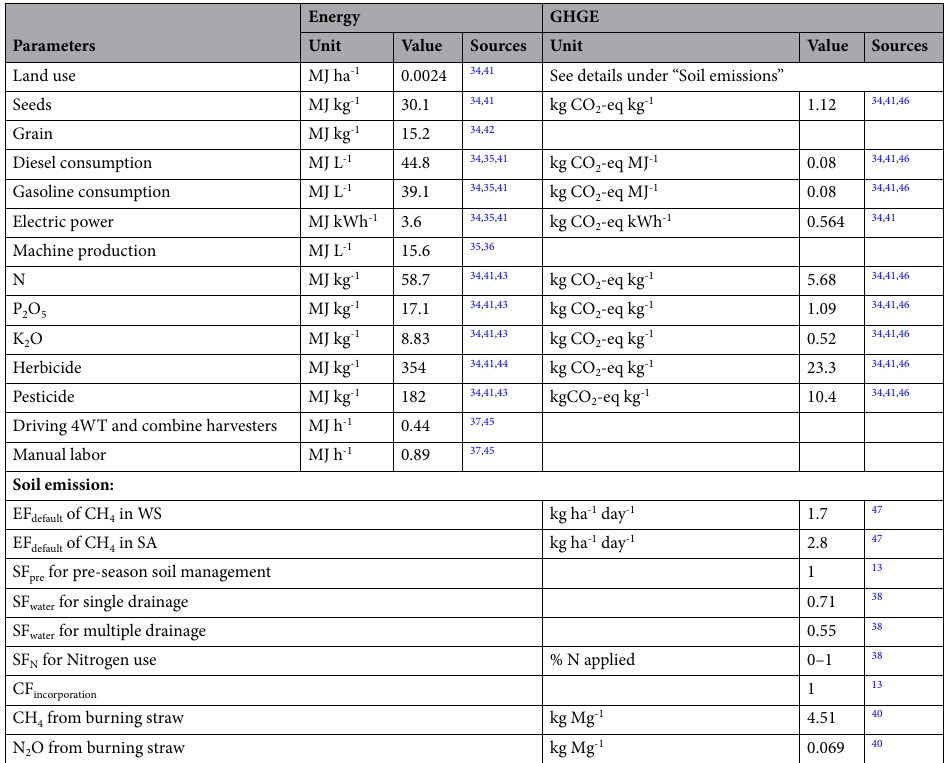
Table 3. Energy and GHGE conversion factors used for calculating the relative energy efficiency of the four crop establishment methods from crop establishment to